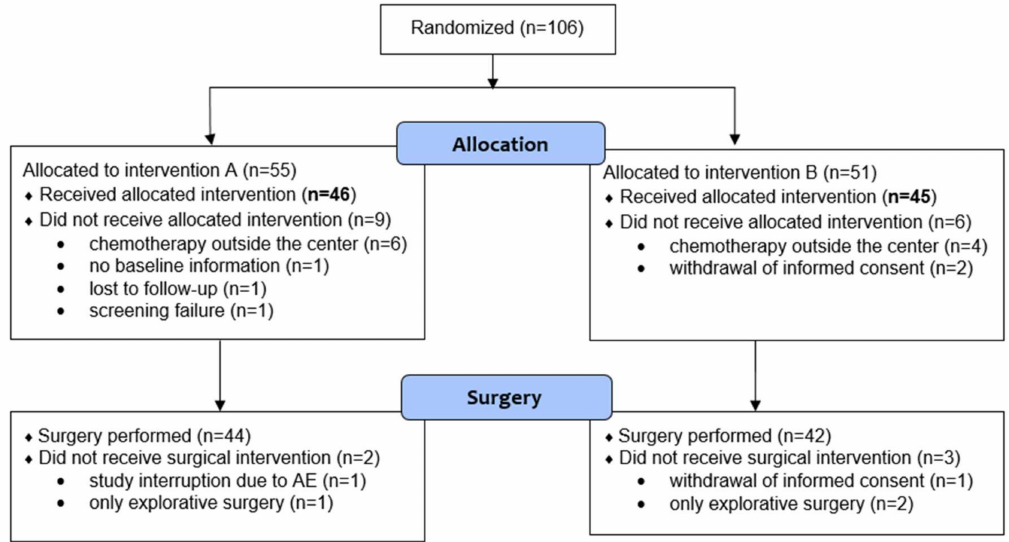
Figure 1. CONSORT diagram for the